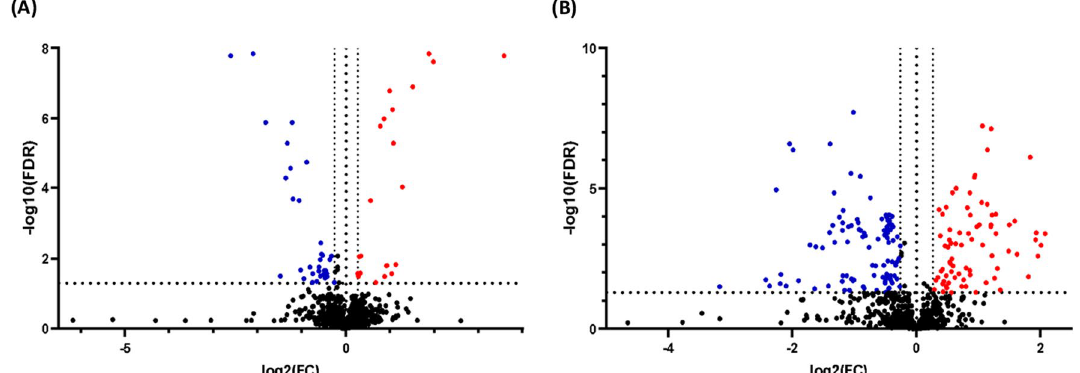
Fig. 4 Volcano plot showing the statistically significant up‑regulated (red circles) and down‑regulated (blue circles) mass features using FDR‑corrected p- value < 0.05, and FC (greater than 1.2 or less than 0.83) in A P. aeruginosa treated with 100 µg/mL micafungin and B P. aeruginosa treated with 8 µg/mL azithromycin, in comparisons to control without